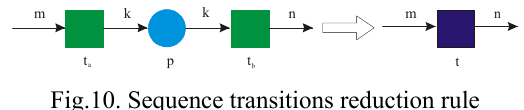
Fig.10. Sequence transitions reduction rule The sequence transitions reduction process in Fig.10